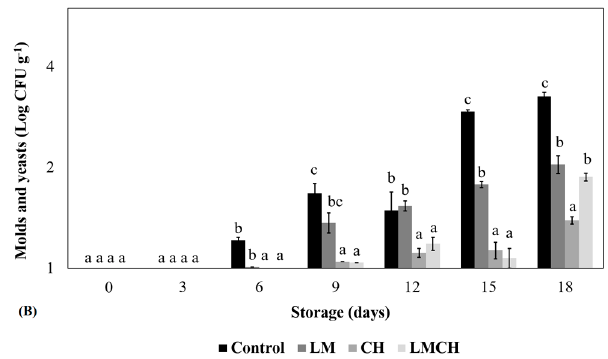
Figure 1. Growth of ( A ) aerobic mesophilic microorganisms (total aerobic counts) and ( B ) molds and yeasts in fresh-cut cantaloupe with and without an edible coating (control) during 18 days of storage at 4 °C. Means which do not have a common letter (a, b, c) are significantly different ( p ≤ 0.05). Vertical bars represent ± SD. LM: linseed mucilage; CH: chitosan; LMCH: linseed mucilage + chitosan.